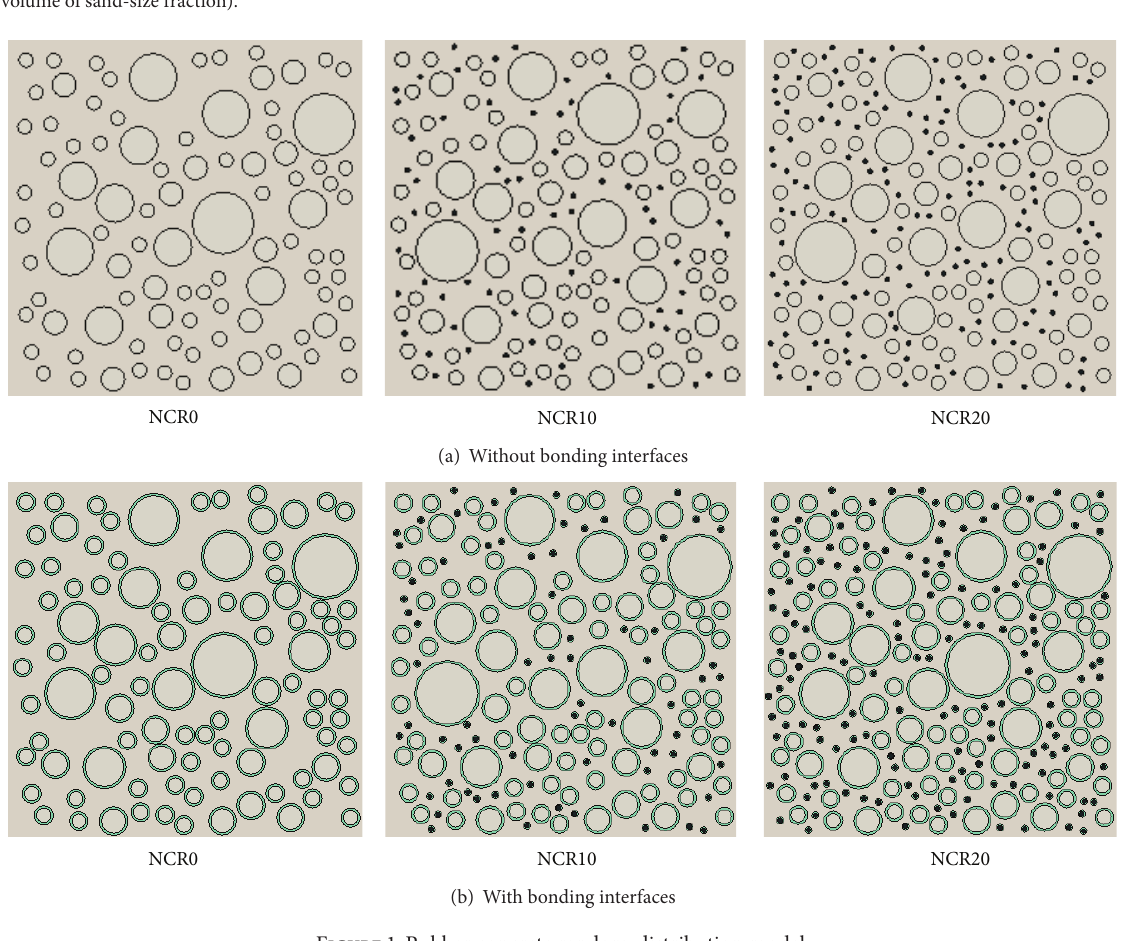
Figure 1: Rubber concrete random-distribution model.